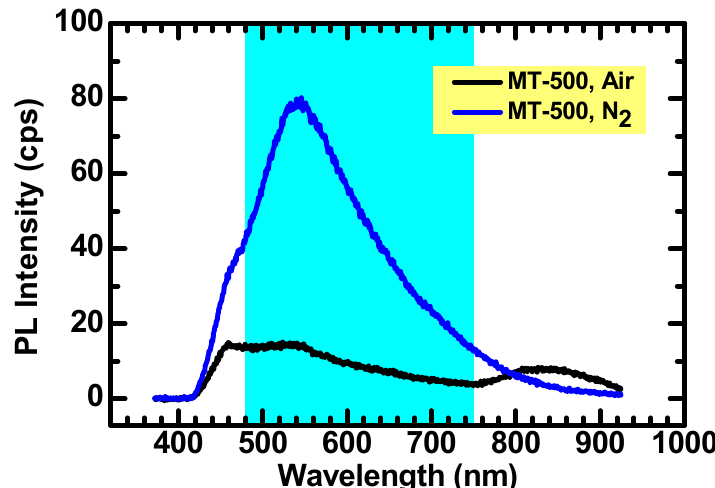
Figure 8. Room-temperature PL spectra of MT-500 acquired in air (black curve) and, after 20 min, exposure to flowing N 2 at 300 sccm flow (blue curve). The cyan-colored region indicates the wavelength interval (i.e., 480–750 nm) used to extract the wavelength-integrated data reported in Figure 9B.